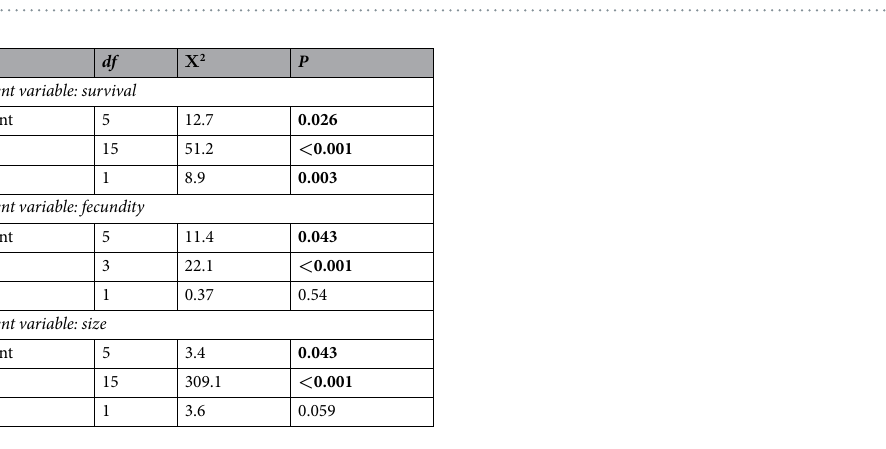
Figure 1. Extracted and transformed logistic regression model coefficients (with standard errors) predicting treatment (line colours) and conspecific density effects (x-axis as number of surviving conspecifics per plate) on the probability of survival (y-axis).